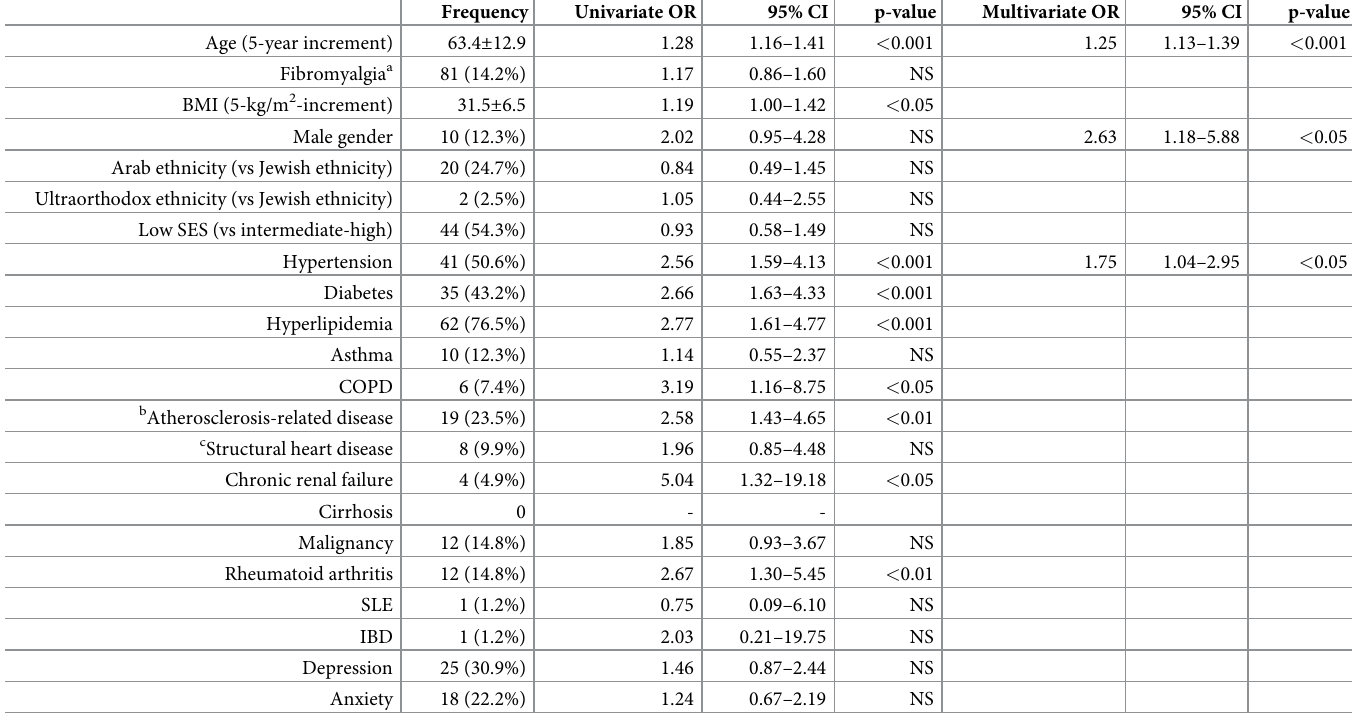
Table 2. Factors associated with COVID-19 hospitalization in patients with fibromyalgia, obtained from a univariate and a multivariate logistic-regression